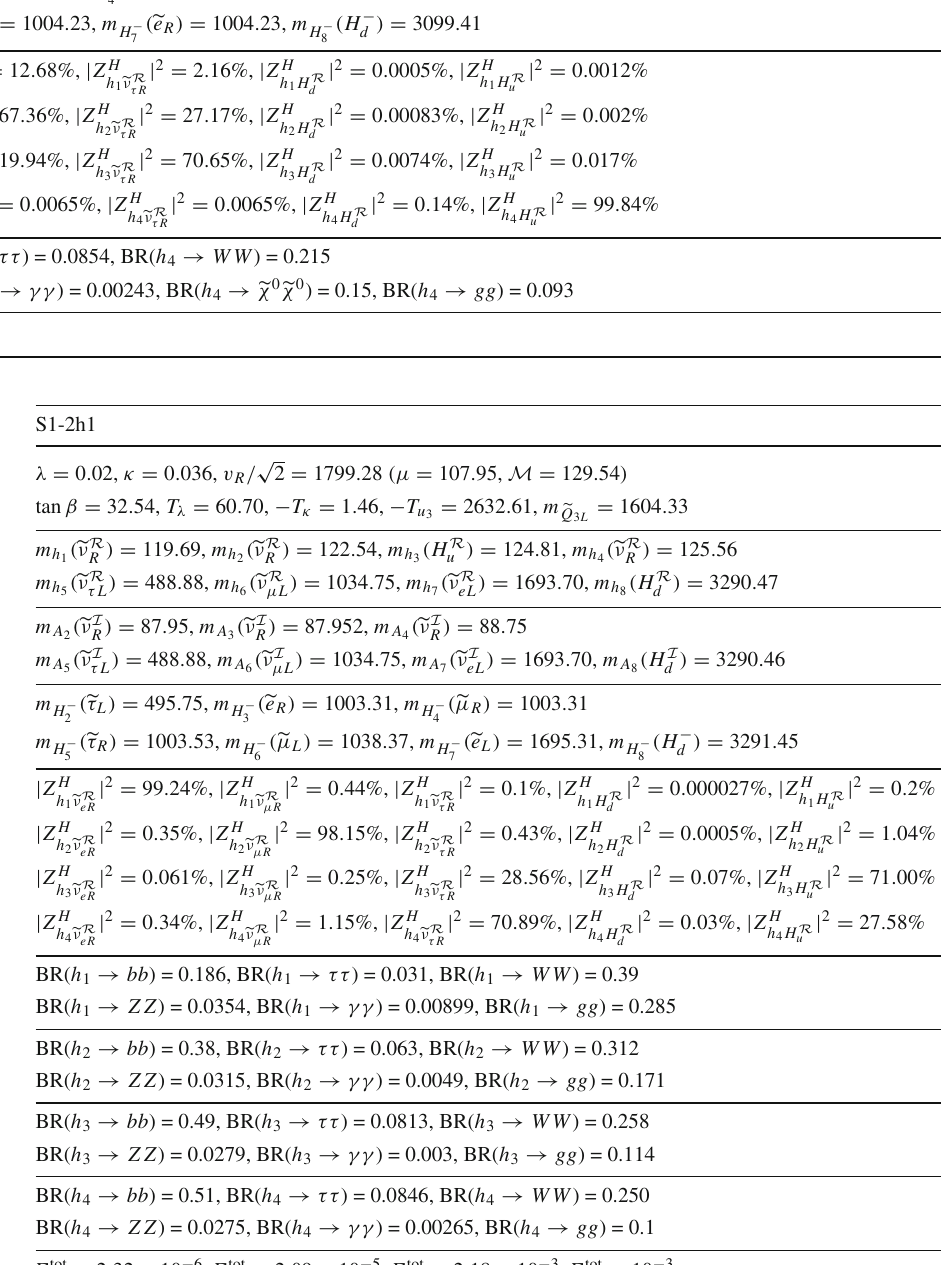
Table 5 The same as in Table 3, but for a benchmark point S1-B1 with the SM-like Higgs h 4 not being the lightest scalar S1-B1